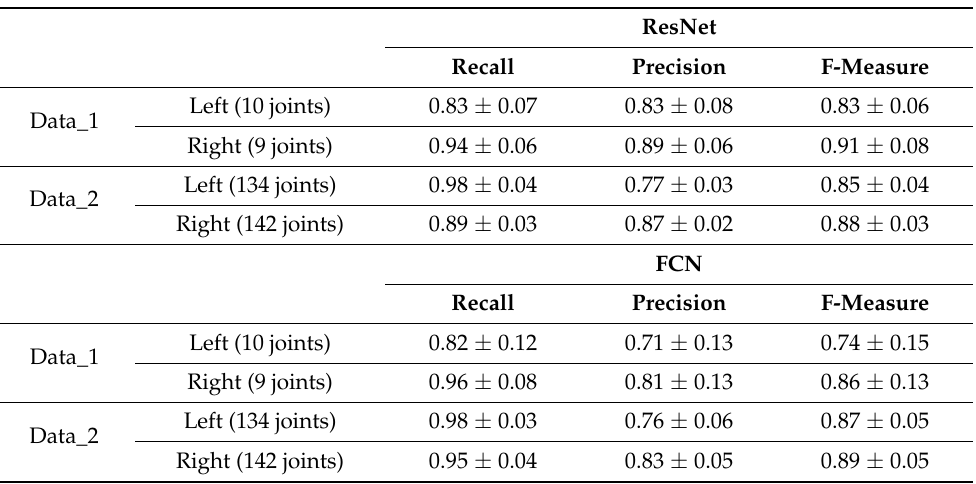
Table 3. Performance of deep learning-based